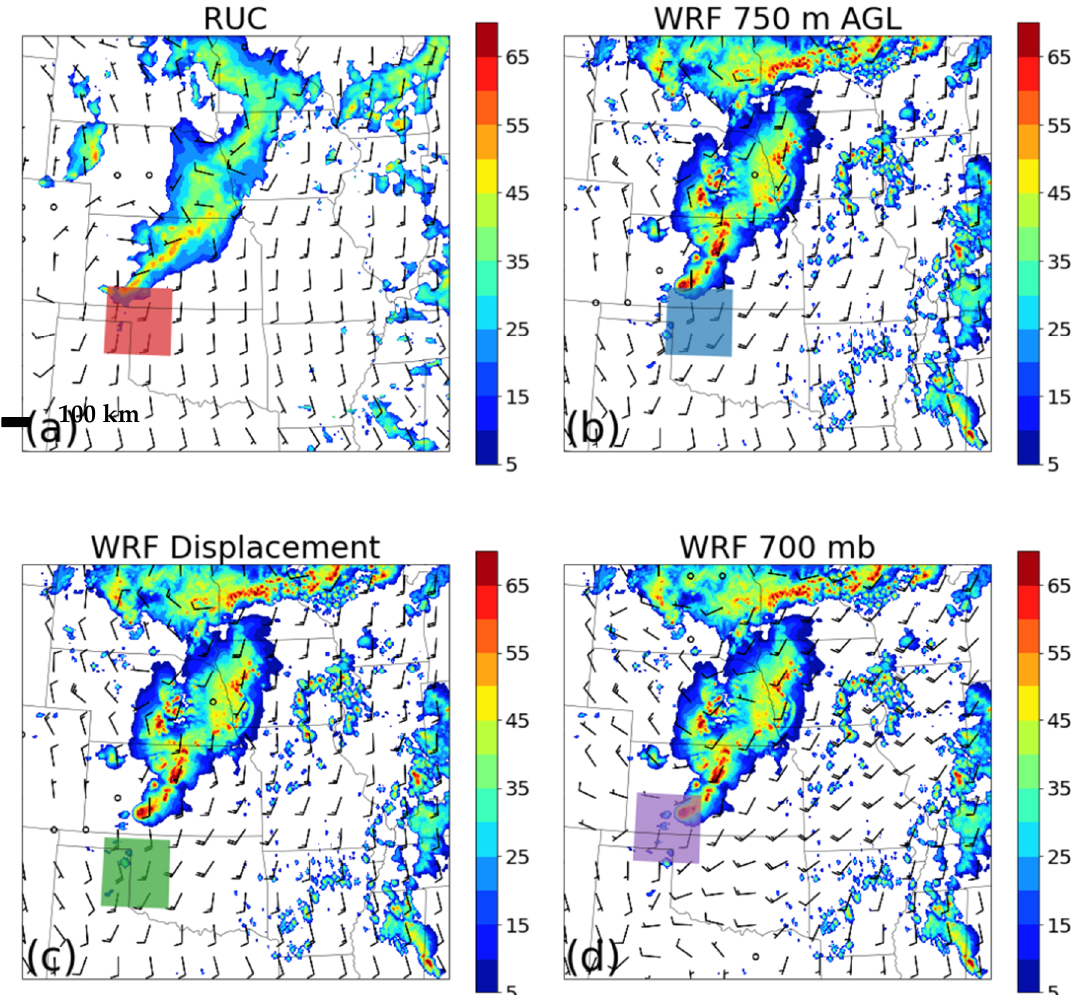
Figure 1. Type C case on 2 June 2014 at 0000 UTC showing all 4 regions used as inflow domains: ( a ) Obs-inflow (red), Rapid Update Cycle (RUC) 750 m AGL wind barbs, and observed mosaic composite reflectivity (see color bar for magnitudes), ( b ) Weather Research and Forecasting (WRF) 750m-inflow (blue), WRF 750 m AGL wind barbs, and simulated composite reflectivity, ( c ) WRFdisp (green), WRF 750 m AGL wind barbs, and simulated composite reflectivity, ( d ) WRF700mb-inflow (purple), WRF 700 mb wind barbs, and simulated composite reflectivity. Distance scale shown at bottom of ( a ).